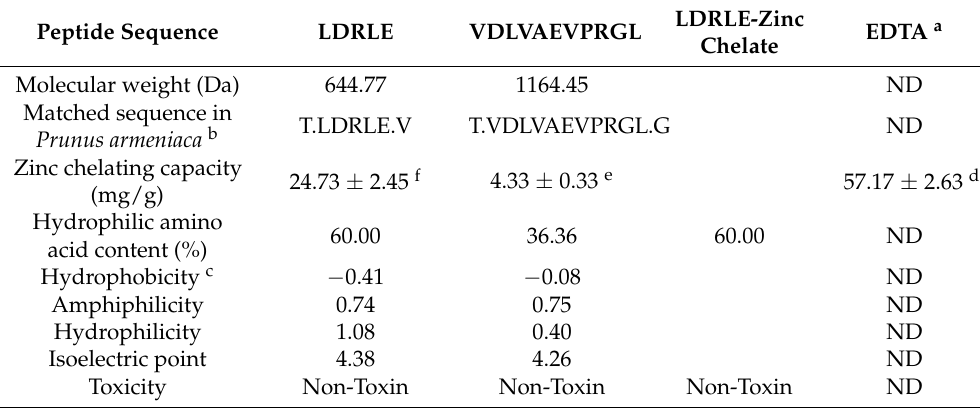
Table 1. Amino acid sequences, antioxidant activity, physicochemical characteristics and toxicity of peptides identified in sweet almond cake amandin hydrolysates.